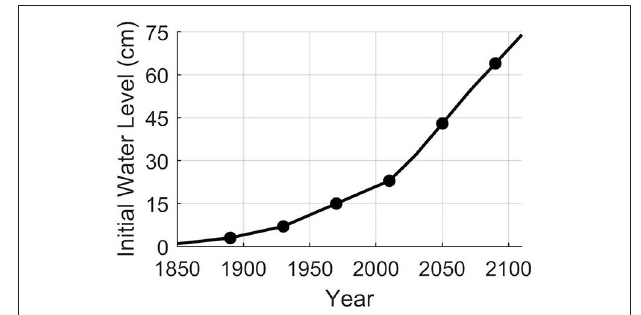
FIGURE 2 | Gulf of Mexico initial water levels for each era used to represent the initial conditions of the hydrodynamic model simulation based on observed historical measurements and a conservative future scenario (i.e., Intermediate-Low scenario from Sweet et al., 2007) of eustatic sea level rise. The dots represents the eras analyzed for the study [Adapted from Siverd et al.